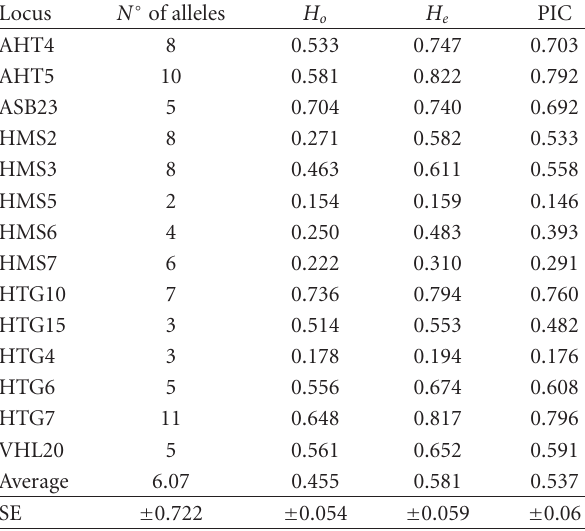
Table 3: Number of individuals, mean number of alleles (MNAs), allelic richness (Ar), observed ( H o ) and expected ( H e ) heterozygosi- ties, and Fis inferred per breed in three Sicilian donkey